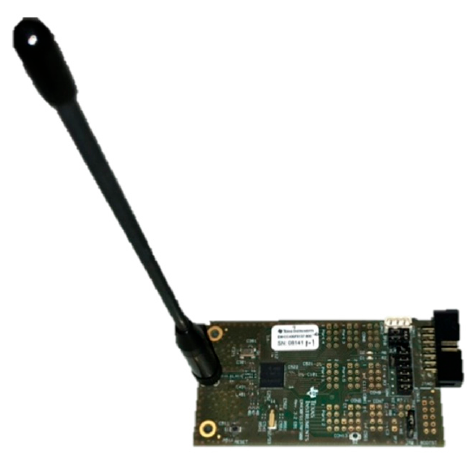
Figure 1. CC430F6137 development board.